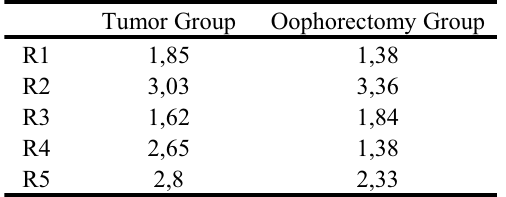
TABLE 4 - Percentage of tumor volume relative to body mass